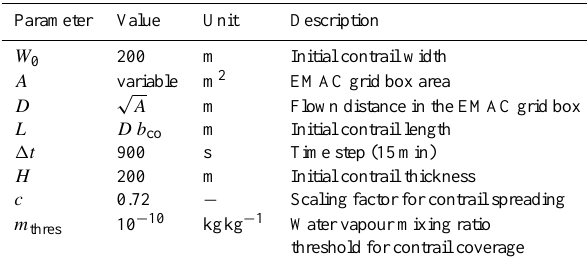
Table 4. Parameters of the contrail parameterisation.